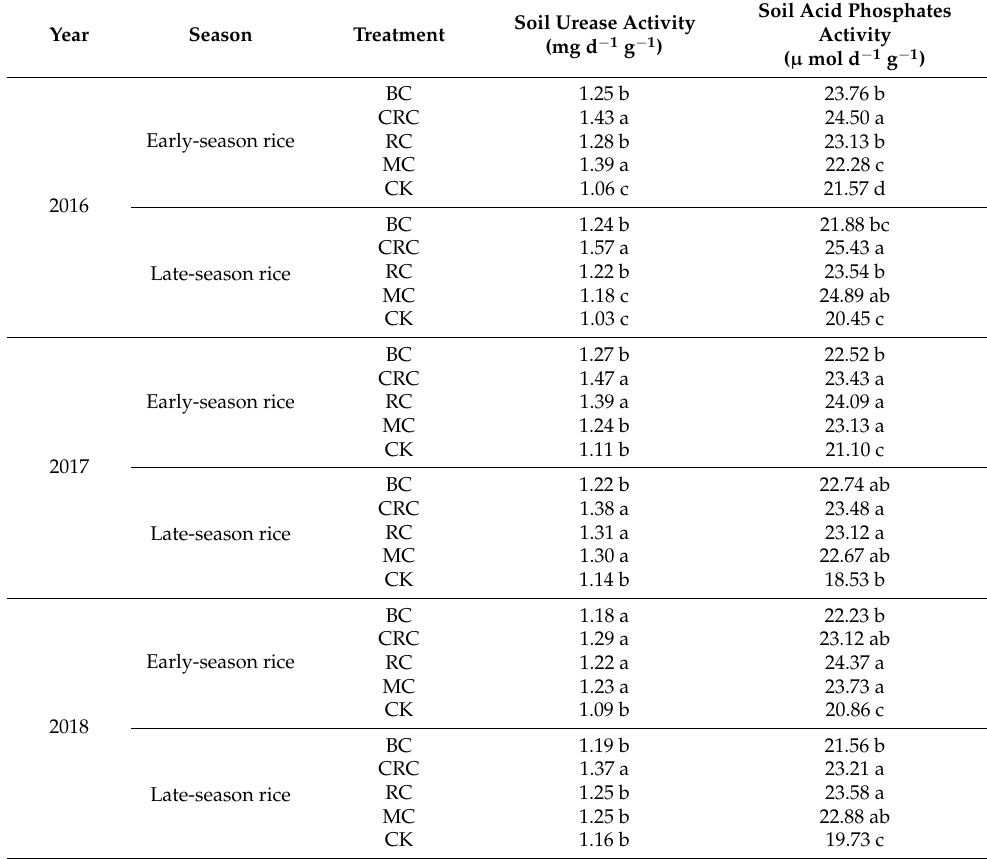
Table 8. Soil enzyme activity under different organic material